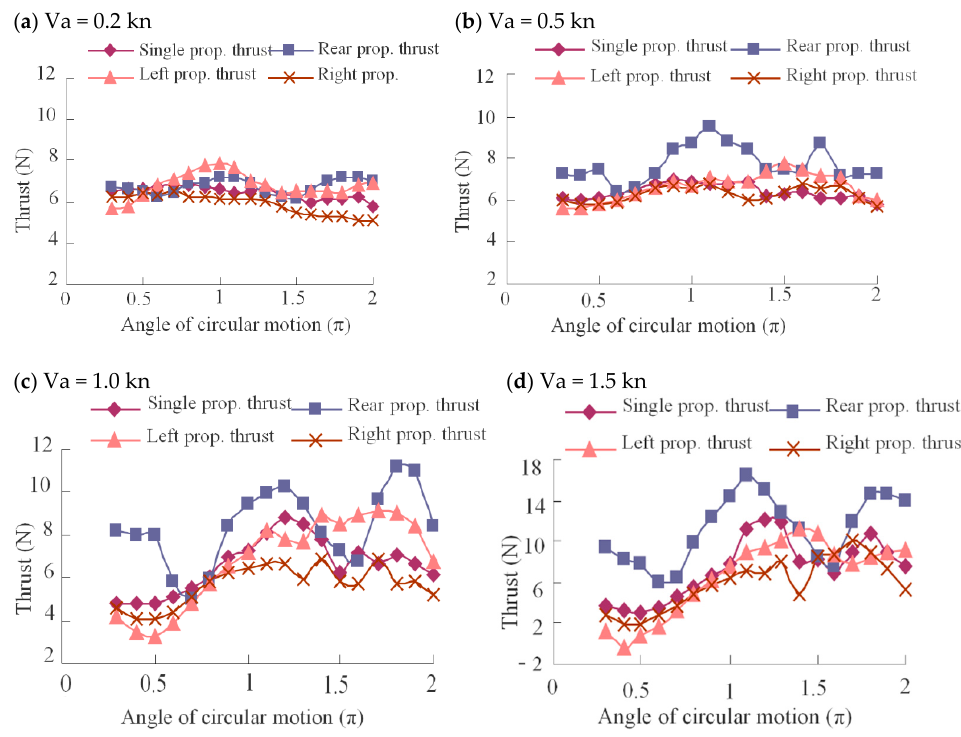
Figure 20. Thrust curves of the three-dimensional circular motion of the underwater robot. ( a ) Va = 0.2 kn; ( b ) Va = 0.5 kn; ( c ) Va = 1.0 kn; ( d ) Va = 1.5 kn. ( a ) Va = 0.2 kn; ( b ) Va = 0.5 kn; ( c ) Va = 1.0 kn; ( d ) Va = 1.5